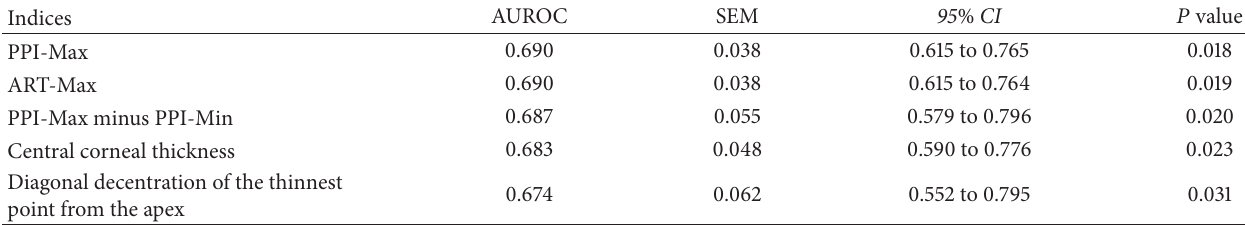
Table 4: Scheimpflug imaging indices differentiating between GROUP 2a KC and normal